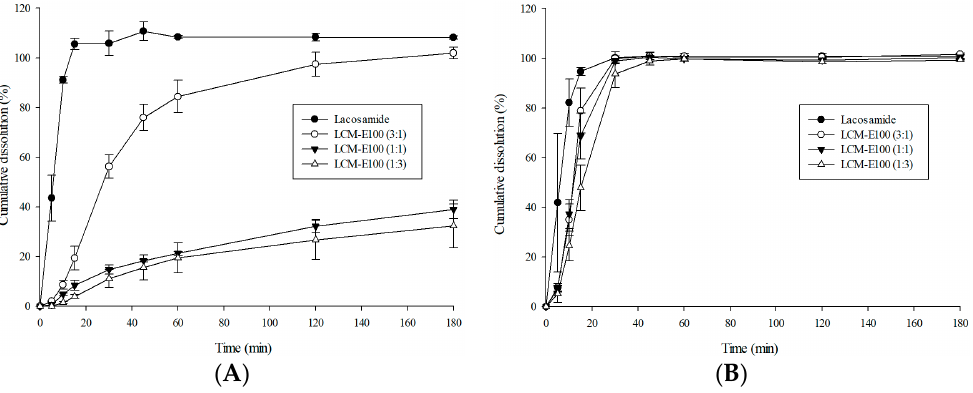
Figure 6. Cumulative dissolution profiles of lacosamide, LCM-E100 (3:1), LCM-E100 (1:1) and LCM-E100 (1:3). ( A ) Dissolution profiles of the prepared formulation at the distilled water, ( B ) Dissolution profiles of the prepared formulation in buffer solution of pH 1.2.